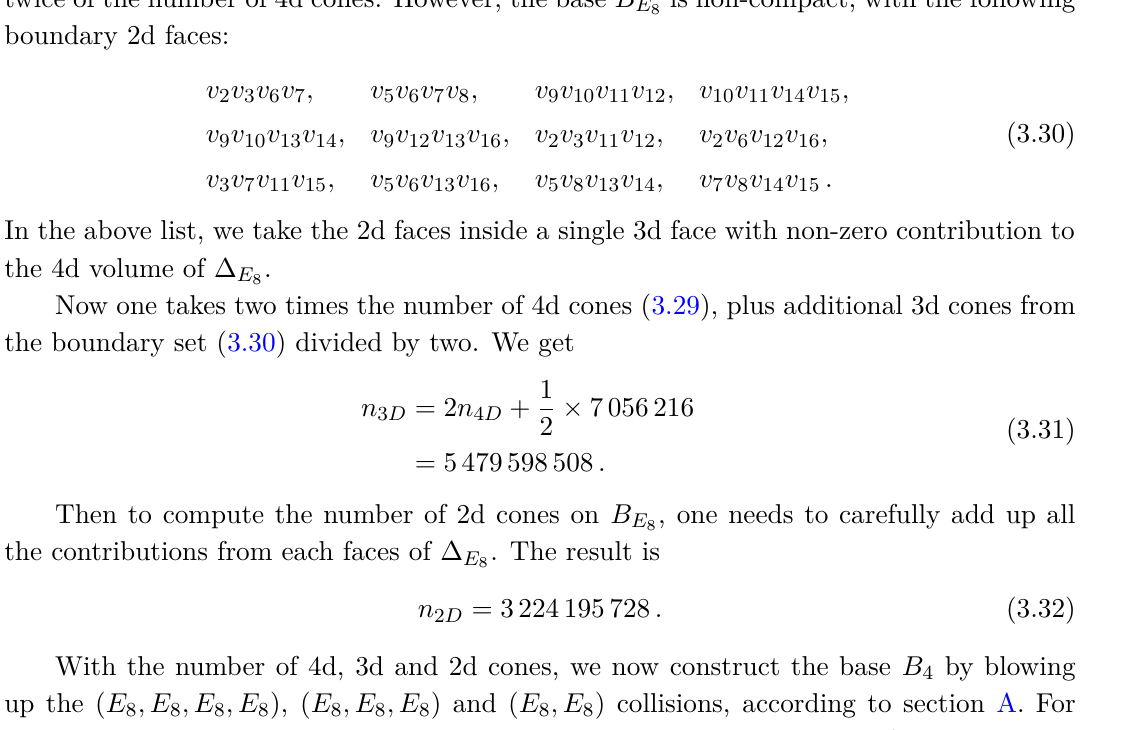
Figure 1 . The vertices of hyper truncated pyramid ∆ E the largest h 1 , 1